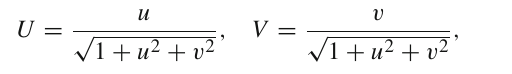
Fig. 12 The phase portrait of system (25) on the Poincaré sphere for the generic scenario (b). Values of parameters are ξ = 3 ε = − 1. Purple arrows denote orbits corresponding to the evolution from the w φ = − 1 equilibrium A to the w φ = − 1 equilibrium E , while the blue arrows denote other orbits. Light grey contours correspond to values of the equation of state parameter w φ . The shaded region is